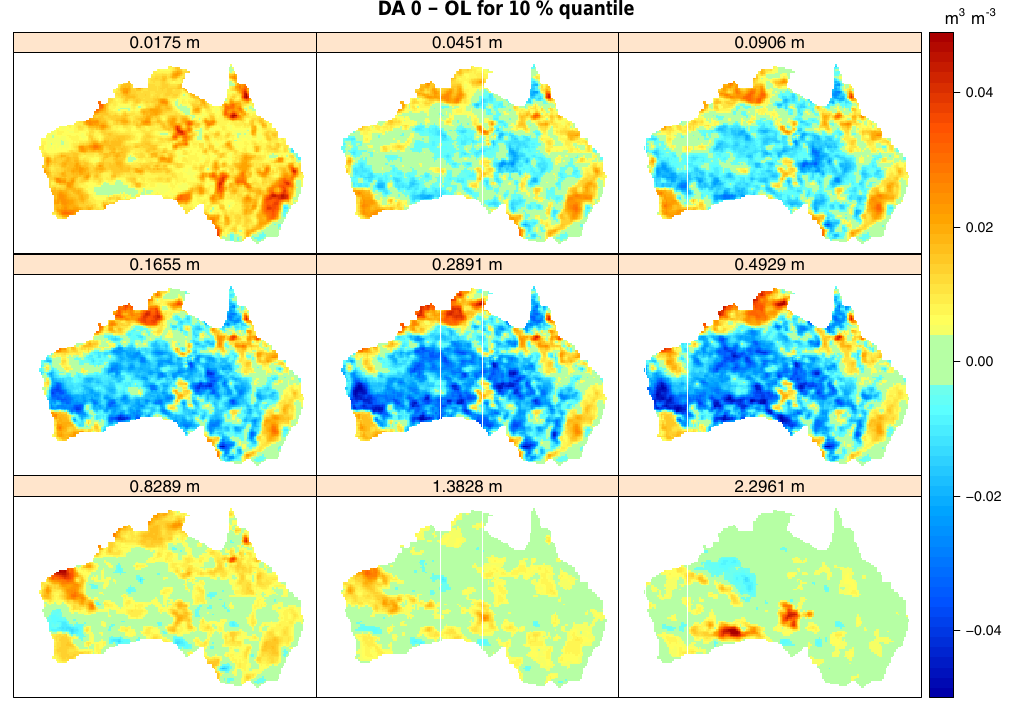
Figure 9. Differences in relative soil moisture between open-loop and DA 0 experiments (DA 0 – OL) for the 10% quantile. The individual panels correspond to the top nine CLM soil layers.